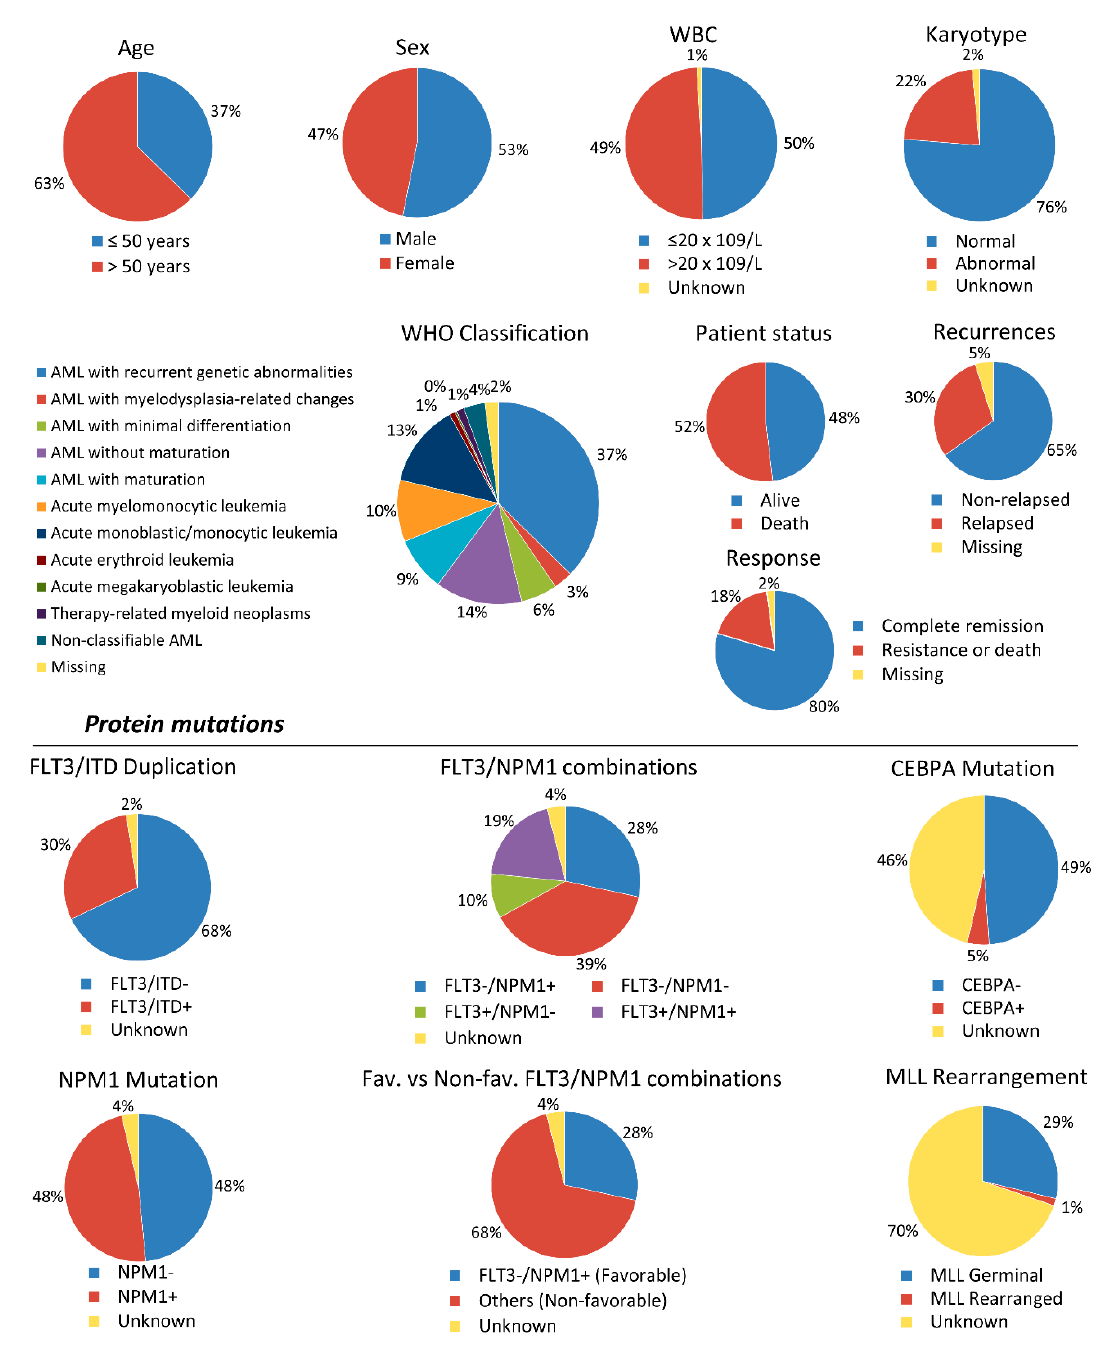
Figure 1. Main clinical characteristics of the studied cytogenetic intermediate-risk acute myeloid leukemia (IR-AML) patient cohort. Results are presented in pie graphs showing percentage of patients for each feature or parameter. WBC; white blood cells. FAB; French-American-British. WHO; World Health Organization. Fav; favorable. Non-fav; non-favorable.